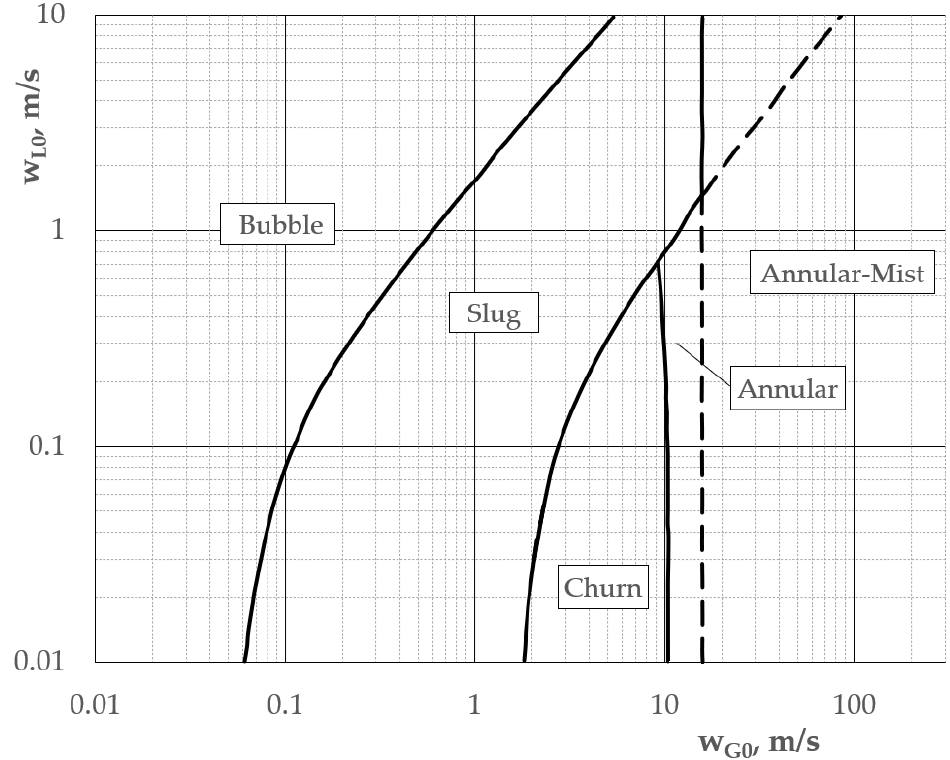
Figure 2. Two-phase flow map according to Mishima and Ishii [46] for the narrow vertical rectangular channel with the areas of flow patterns indicated.